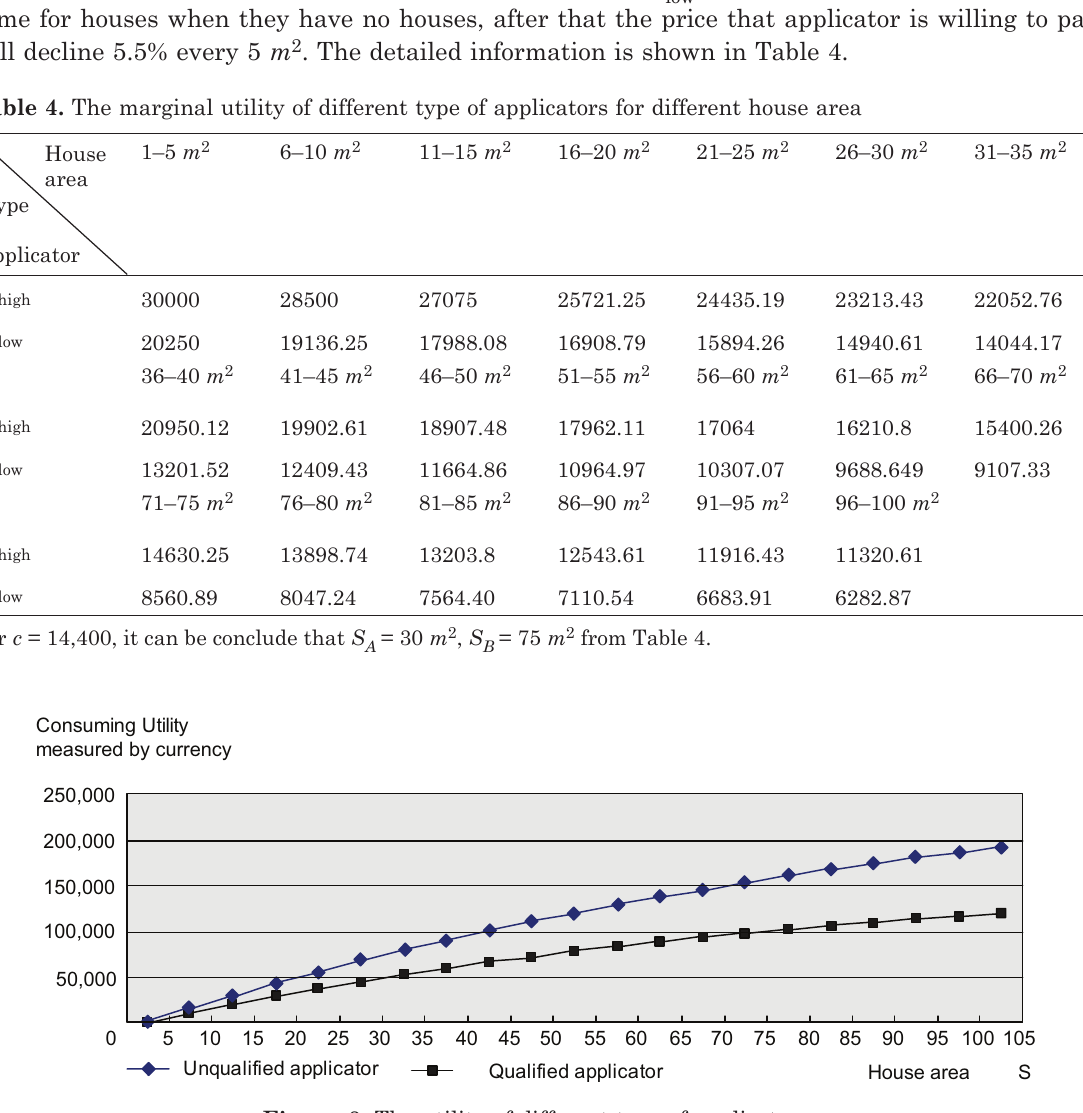
figure 8. The utility of different type of